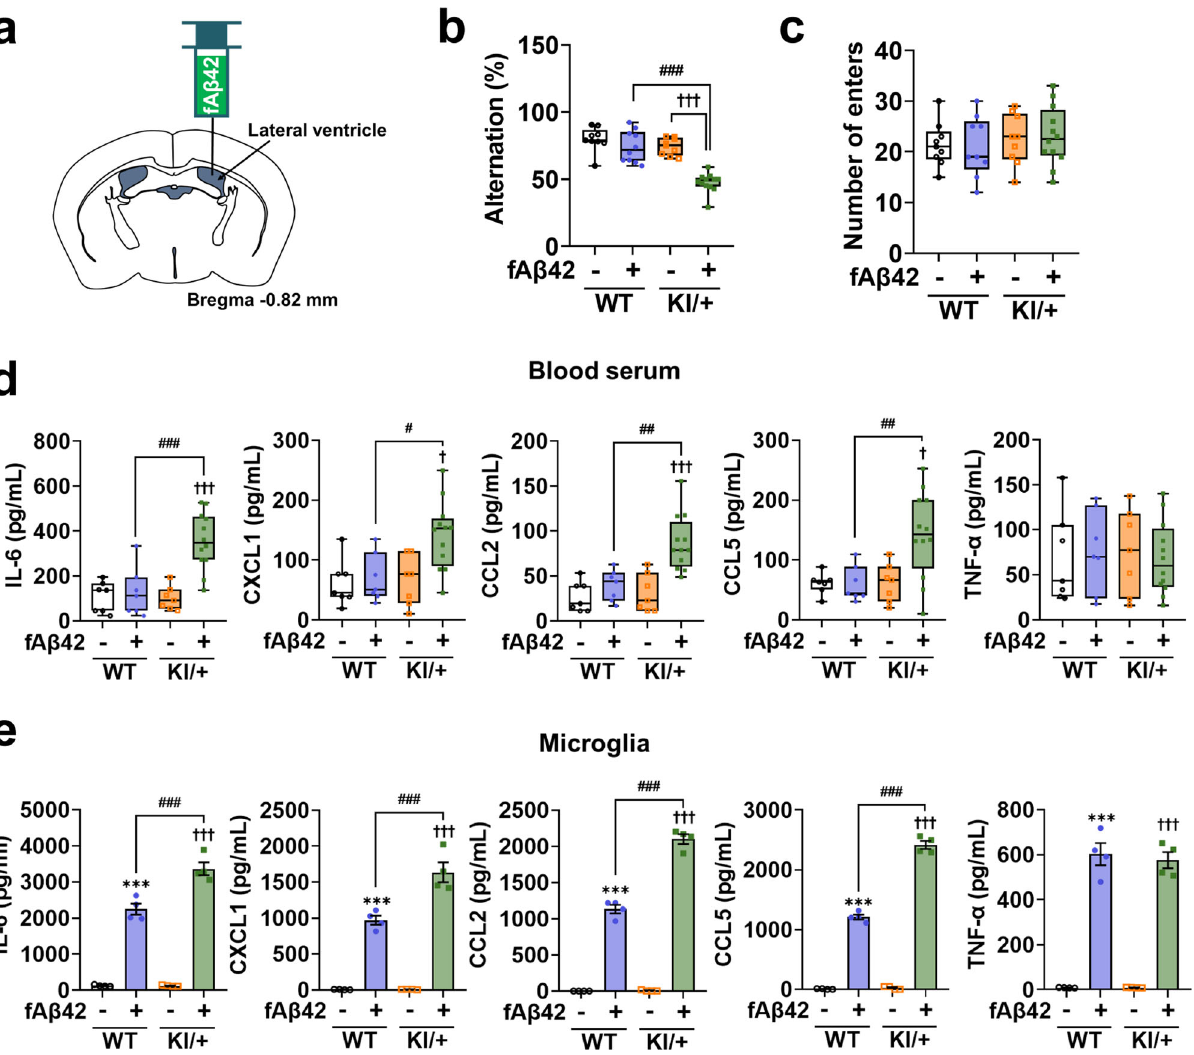
Fig. 4 Fibrillar amyloid beta42 (fA β 42) increases secretion of clock gene-controlled cytokines and induces memory de fi cits in Psen2 N141I/ + mice. a Coordination of the stereotaxic surgery. b , c Y-maze test with WT and KI/ + mice (8-week-old, male, n = 12 mice for fA β 42-injected KI/ + ; n = 7 mice for other groups) 7 days after fA β 42 (1.25 nM) i.c.v. injection for assessment of spatial working memory (KI/ + vs fA β 42-injected KI/ + : ††† p < 0.0001; fA β 42- injected WT vs fA β 42-injected KI/ + : ### p < 0.0001; one-way ANOVA). d ELISA of clock gene-controlled cytokines (IL-6, CXCL1, CCL2, and CCL5) and TNF- α in blood serum from WT and KI/ + mice (8-week-old, male, n = 12 mice for fA β 42-i n jected KI/ + ; n = 7 mice for other groups) 7 days after fA β 42 (1.25 nM) i.c.v. injection (KI/ + vs fA β 42-injected KI/ + : ††† p < 0.0001, † p = 0.0109, ††† p = 0.0002, and † p = 0.0103; fA β 42-injected WT vs fA β 42- injected KI/ + : ### p = 0.0003, # p = 0.016, ## p = 0.0014, and ## p = 0.0087; one-way ANOVA). The bounds of the box represent 25th to 75th percentiles ranges. The center lines with the box represent the mean value and whiskers represent the minimum to the maximum range ( b – d ). e ELISA of clock gene- controlled cytokines (IL-6, CXCL1, CCL2, and CCL5) and TNF- α in the culture media of WT and KI/ + microglia after fA β 42 (4 μ M) treatment for 24 h ( n = 4) (untreated WT vs fA β 42-treated WT: *** p < 0.0001; untreated KI/ + vs fA β 42-treated KI/ + : ††† p < 0.0001; fA β 42-treated WT vs fA β 42-treated KI/ + : ### p = 0.0001, ### p = 0.0003, ### p < 0.0001, and ### p < 0.0001; one-way ANOVA). Data are mean ± SEM. *** p < 0.001 vs untreated WT control. † p < 0.05, and ††† p < 0.001 vs untreated KI/ + control. # p < 0.05, ## p < 0.01, and ### p < 0.001 for the indicated com p arisons. Source data are provided as a Source Data fi